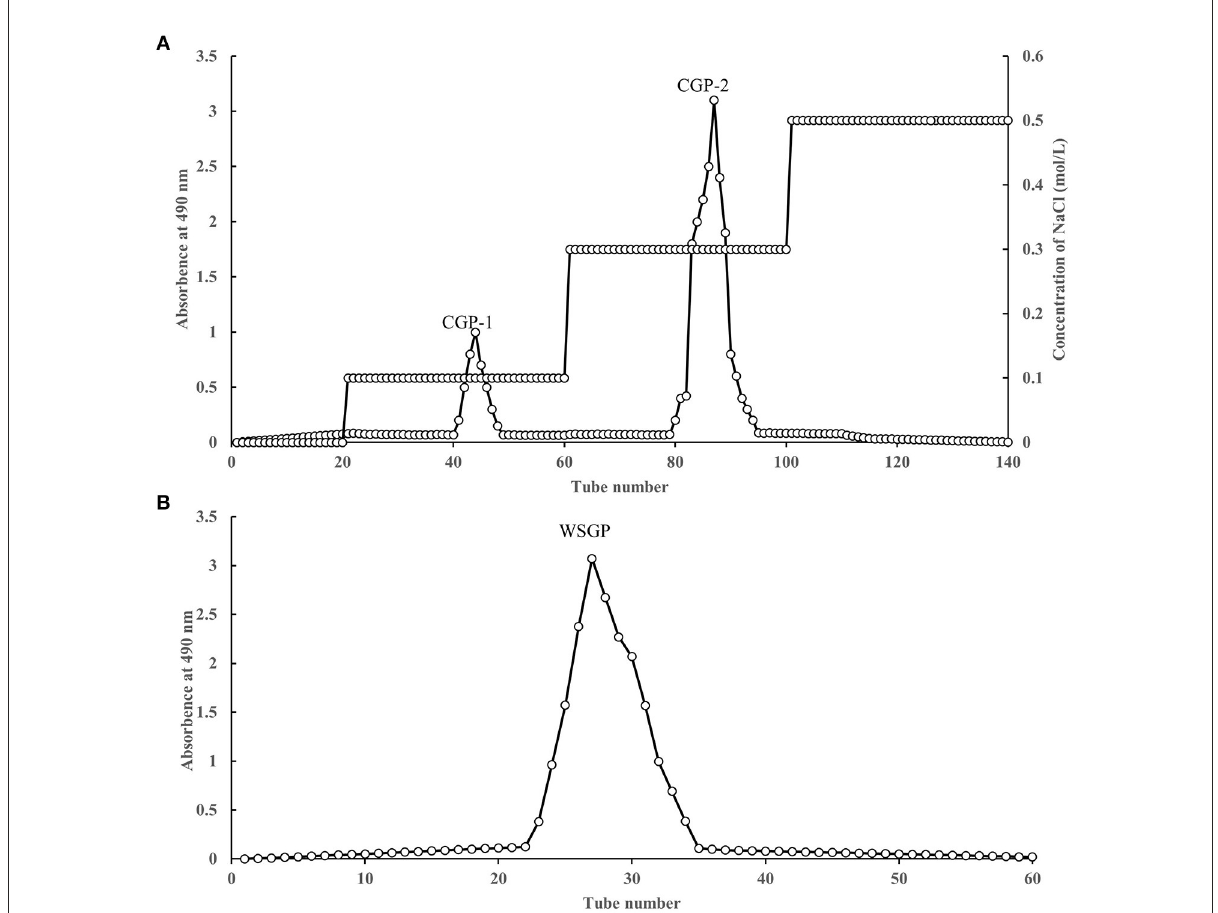
FIGURE1 Stepwise elution curve of crude polysaccharides on DEAE-52 column (A) and elution curve of polysaccharides fraction (F-1) on SephadexG-100 column (B) .